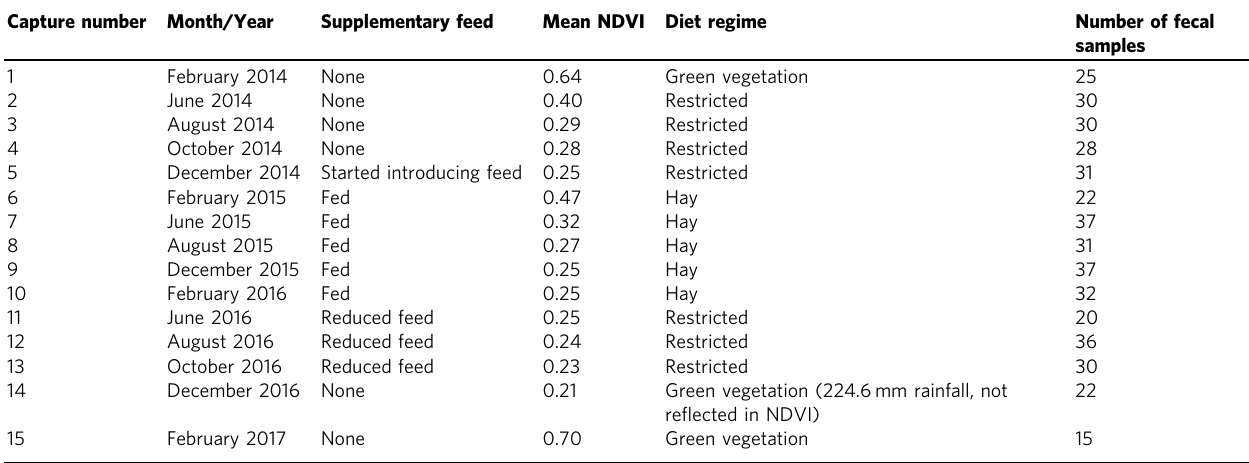
Table 4 Distribution of sample sizes and sampling dates from across the three diet regimes.